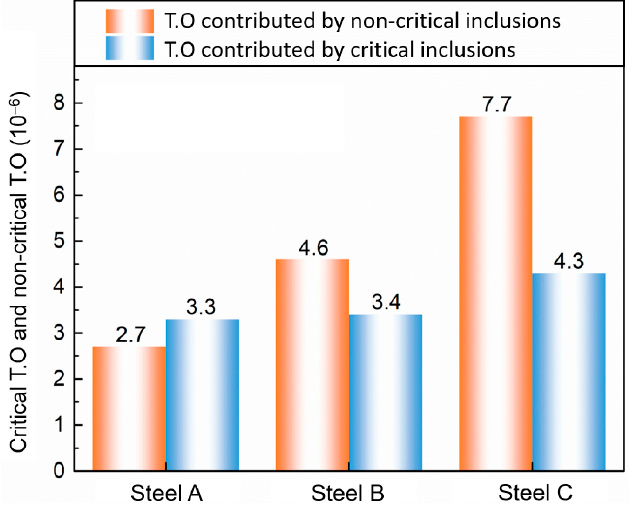
Figure 13. Histograms of [O] ox sorted by types: ( a ) Spinel inclusions in steel A; ( b ) calcium aluminate inclusions in steel A; ( c ) silicate inclusions in steel A; ( d ) spinel inclusions in steel B; ( e ) calcium aluminate inclusions in steel B; ( f ) silicate inclusions in steel B; ( g ) spinel inclusions in steel C; ( h ) calcium aluminate inclusions in steel C; ( i ) silicate inclusions in steel C.